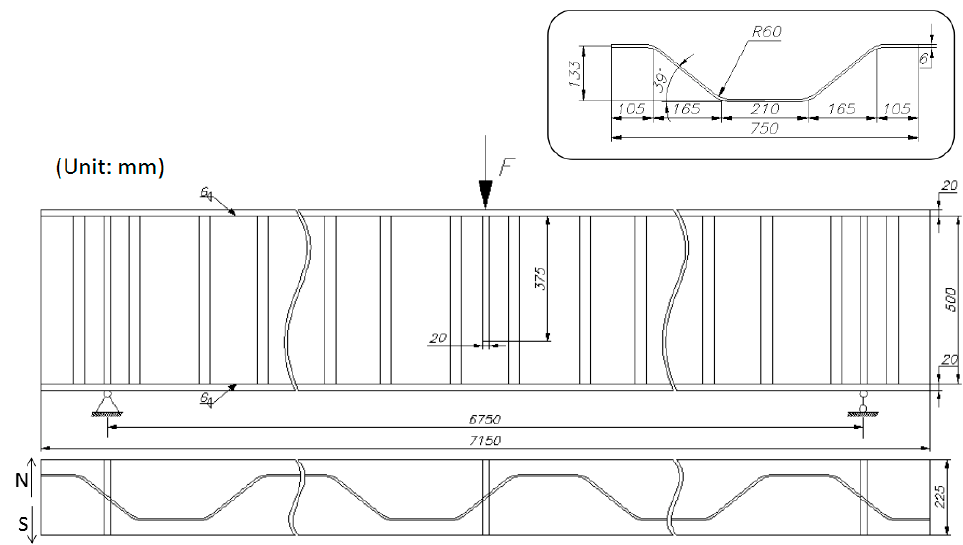
Figure 3. Geometry of the corrugated web girder specimen.